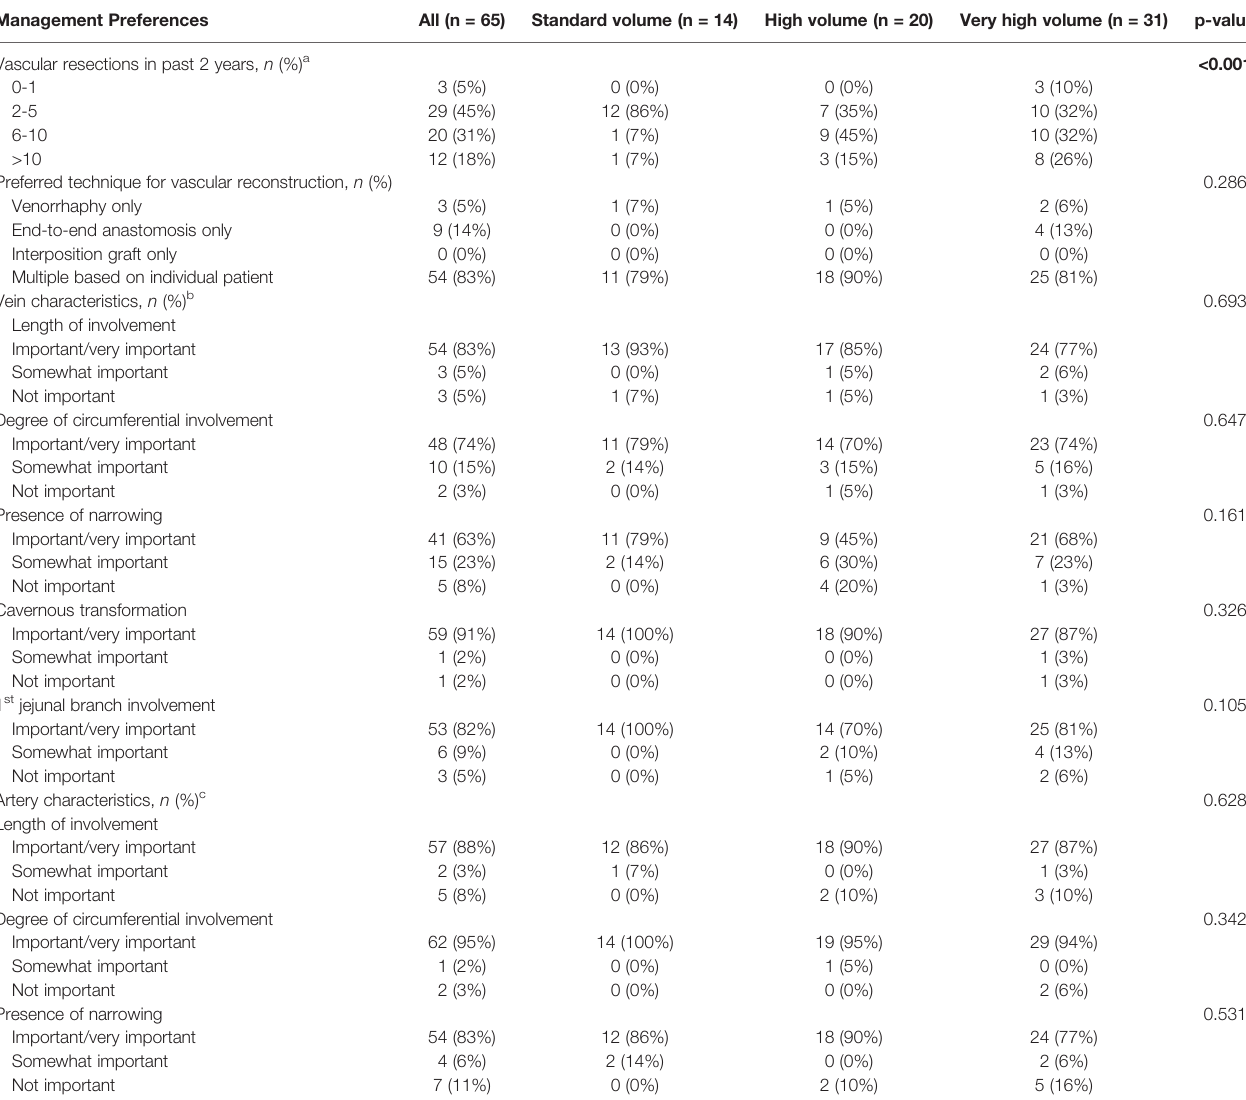
TABLE 2 | Technical surgical considerations in the management of borderline resectable and locally advanced pancreatic adenocarcinoma. Management